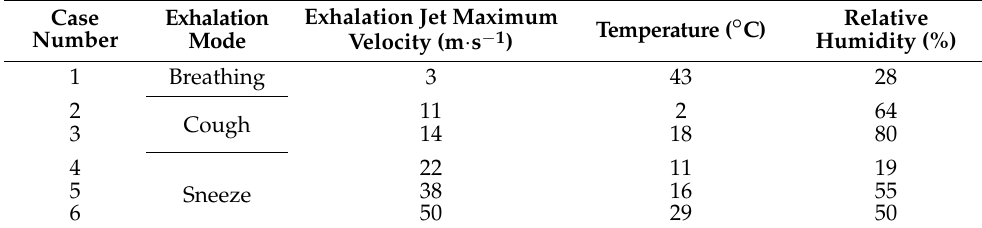
Table 3. Characteristics of the defined exhalation scenarios.